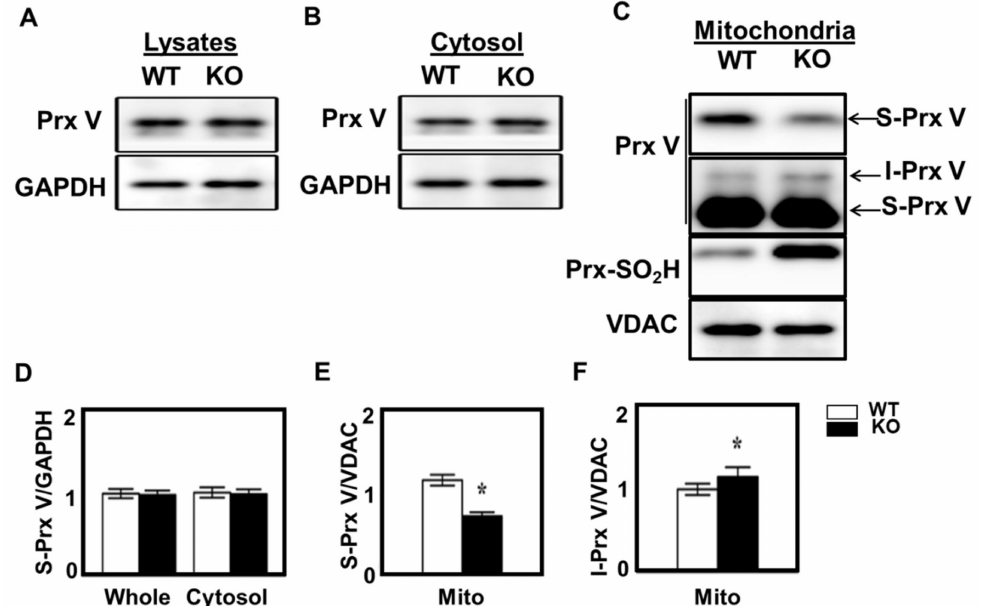
Figure 5. Effect of Srx deletion on L-Prx V maturation in adrenal gland. Whole lysates ( A ), cytosolic ( B ), and mitochondrial ( C ) fractions obtained after subcellular fractionation of adrenal gland homogenates from wild type and Srx KO mice were subjected to immunoblot analysis with antibodies to indicated proteins. Two different blot exposures are shown for Prx V blot in ( C ). The band intensities of S-Prx V in whole lysates and cytosol are normalized to the intensity of GAPDH ( D ), and the band intensities of S-Prx V and I-Prx V in mitochondria are normalized to the intensity of VDAC ( E , F ). Data are means ± SE ( n = 3 per group),* p <